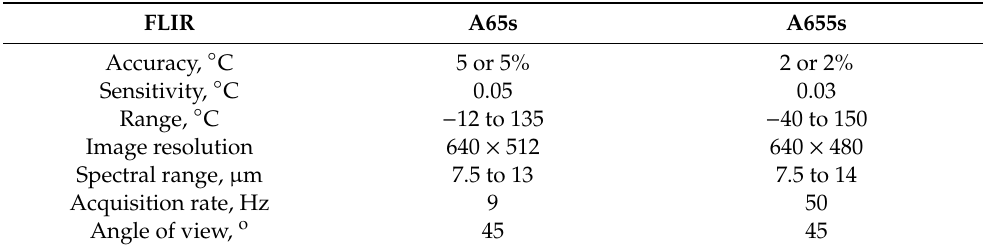
Table 1. Details of the two infra-red (IR) cameras